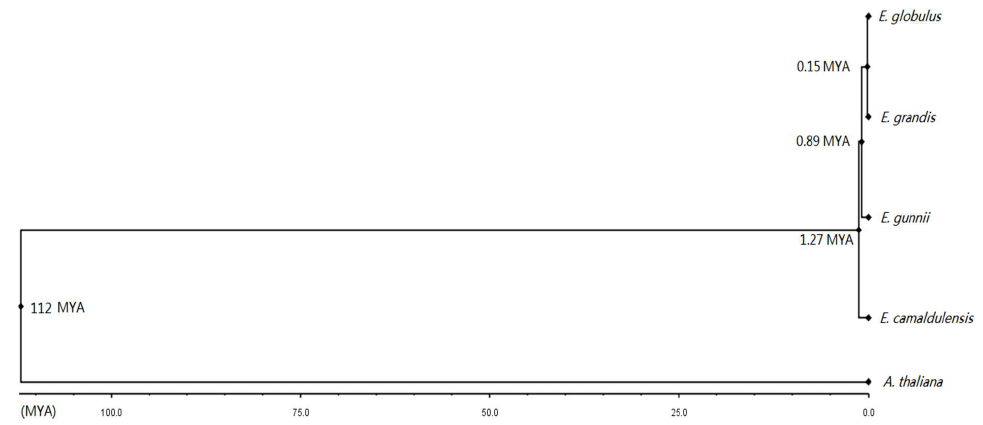
Figure 8. Divergence time of the four Eucalyptus species. For each organism the chimerical gene of 49 ROS genes was used in this study. The divergence time between Eucalyptus species was written beside the nodes. Million years ago (MYA).